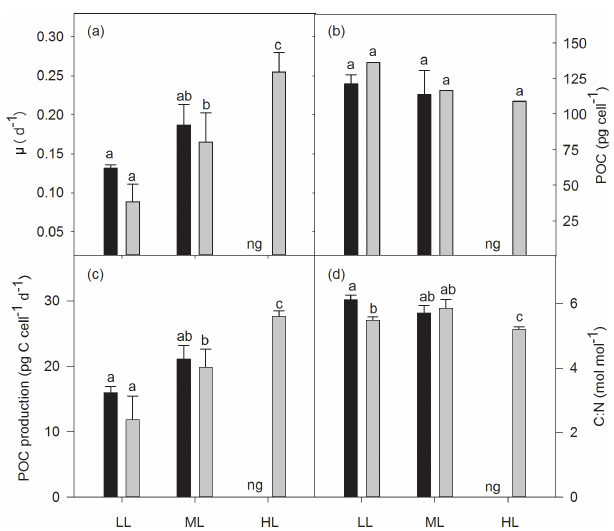
Figure 1. Growth rate (a) , cellular content (b) , and production rate (c) of particulate organic carbon (POC) and the molar ratio of carbon to nitrogen (C : N, d ) for Geminigera cryophila acclimated to ambient (black bars) or high CO 2 (gray bars) conditions com- bined with low (LL), medium (ML) or high light (HL). G. cryophila did not grow under ambient p CO 2 and HL as indicated by ng. Val- ues represent the means ± SD ( n = 3). Different letters indicate sig- nificant differences between treatments ( p < 0 . 05). Table 2. Cellular concentrations of chlorophyll a and c 2 (Chl a and c 2 ) as well as alloxanthin (Allo) were determined for Geminigera cryophila acclimated to ambient or high CO 2 conditions combined with low (LL), medium (ML) or high light (HL). G. cryophila did not grow under ambient p CO 2 and HL as indicated by ng. Pho- tosynthetic parameters were derived from at least three indepen- dent measurements. Different letters indicate significant differences between treatments ( p < 0 . 05). Values represent the means ± SD. Here, “fg” denotes